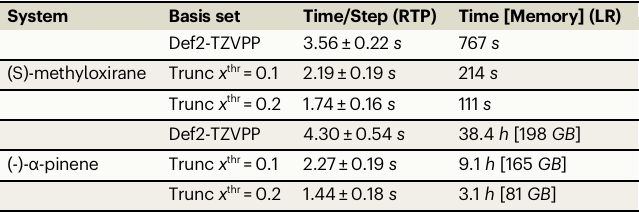
Table 2 | Benchmark of the original and truncated basis sets of def2-TZVPP used in ( S )-methyloxirane and (-)- α -pinene